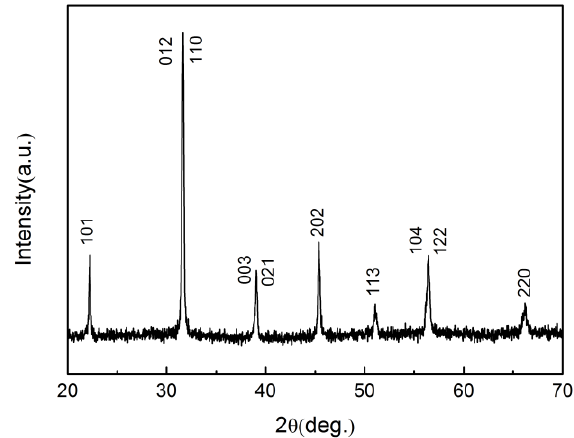
Figure 1. XRD pattern of the BFO-BTO+Mn ceramic.